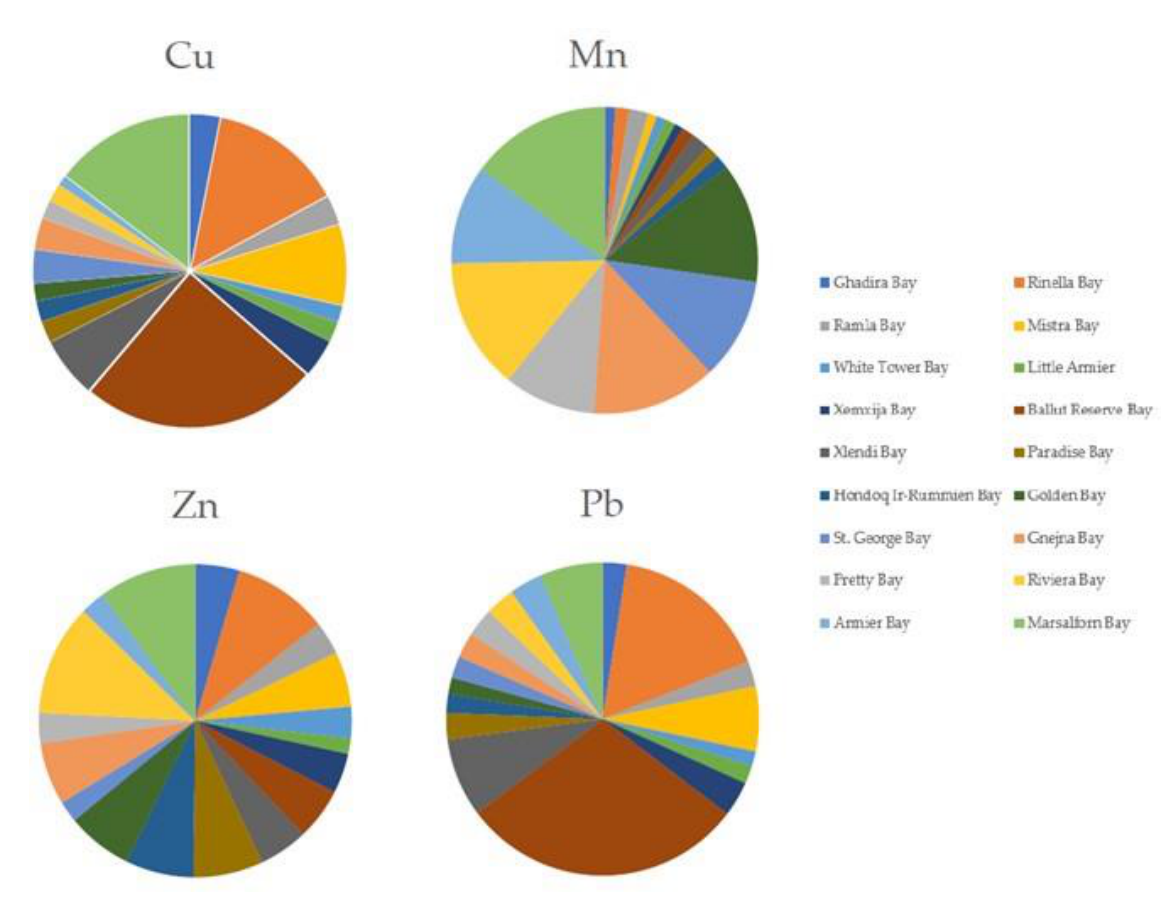
Figure 5. Pie charts representing monomial potential ecological risk factor (Ei) values for different heavy metals across sand beaches in Malta and Gozo. heavy metals across sand beaches in Malta and